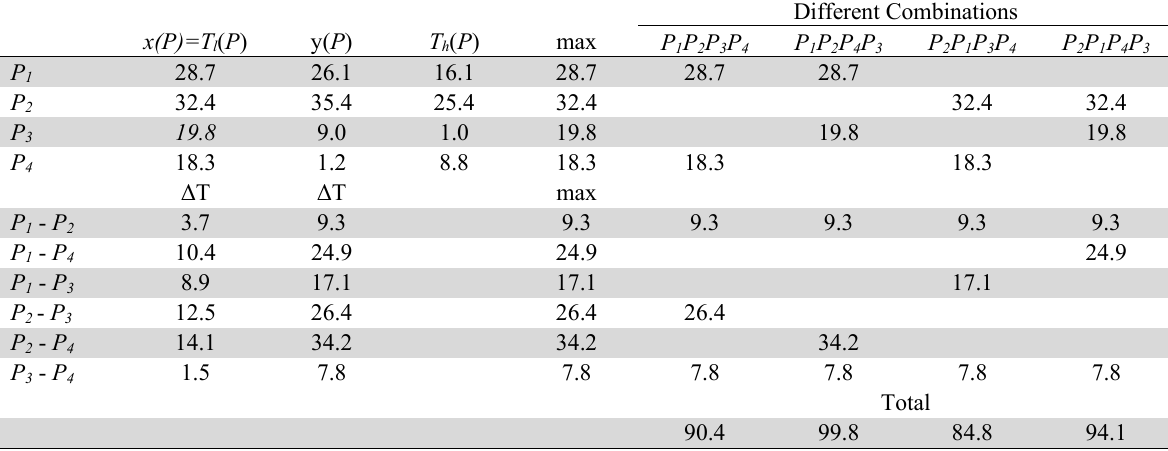
Generation of points and computation of times [s]